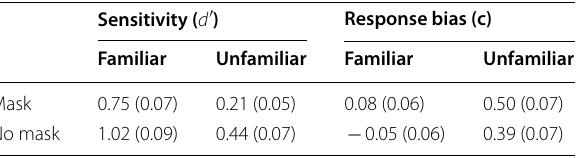
Descriptive statistics [mean(standard error of the mean)] for the measures sensitivity ( d ′ ) and criterion ( c ) Results are shown separately for familiarity and the presence of a mask in the study